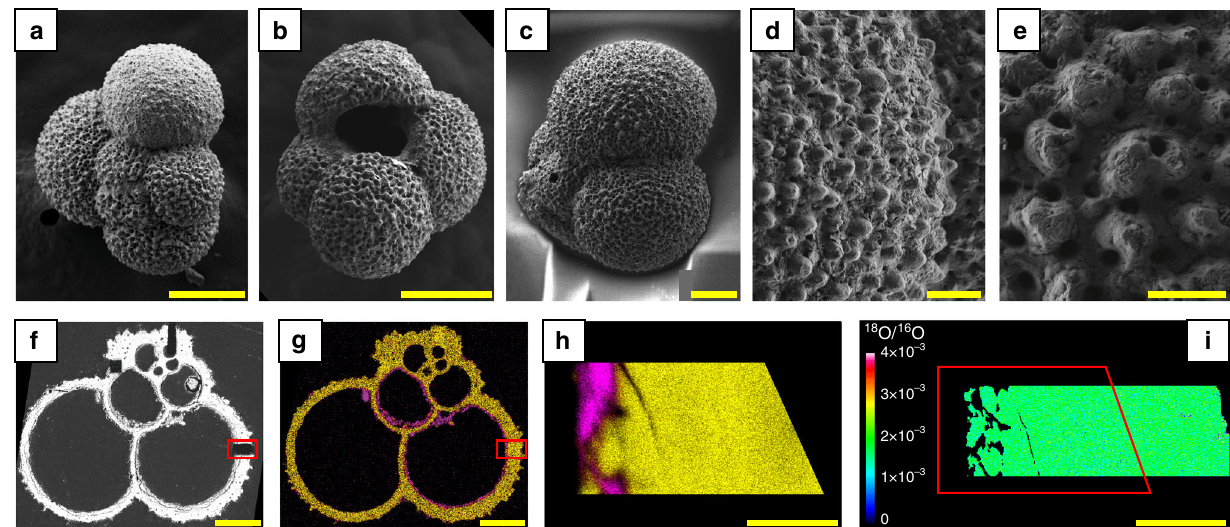
Fig. 1 Foraminifera tests prior to isotope re-equilibration experiments. a – e SEM images showing the overall morphologies and ultrastructures of the foraminifera tests ( G. bulloides ) after their ultrasonic cleaning in pure ethanol. f Backscattered SEM image of a polished section of a test embedded in epoxy. g , h Energy dispersive X-ray spectroscopy (EDXS) maps showing the spatial distributions of carbonates (Ca appears in yellow) and clays (Si appears in pink). i NanoSIMS map displaying the isotopically homogeneous nature of the carbonates and clays ( 18 O/ 16 O = 0.002). The red rectangles in f , g indicate the locations of i . The red rectangle in i indicates the location of h . Scale bars are 100 µ m ( a , b , f , g ), 50 µ m ( c ), 20 µ m ( d , i ) and 10 µ m ( e , h